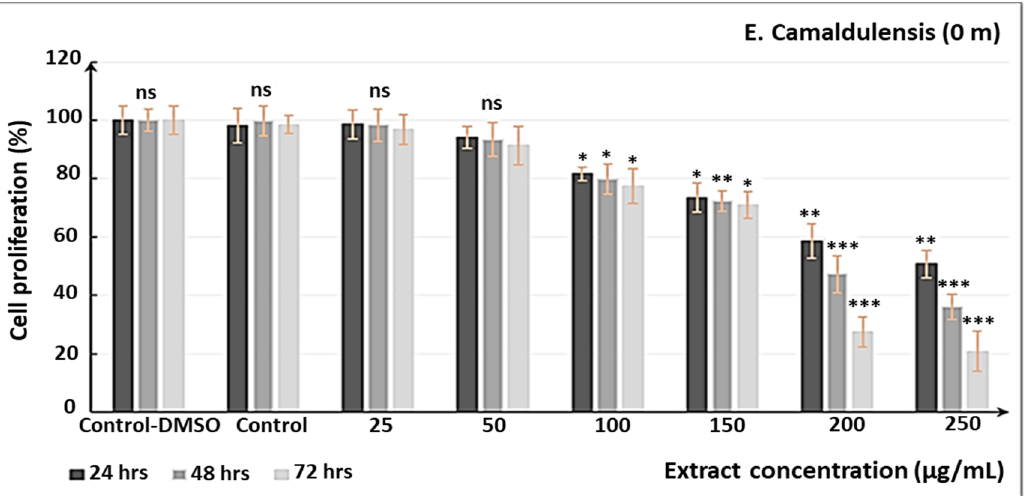
Figure 6 . Cell proliferation of A549 cells after the exposure to ethanolic extract of E. camaldulensis (0 m) for 24, 48 and 72 h. Peak values are represented as mean +/ − SD. Statistical analysis: Paired t test or Wilcoxon test. * p < 0.05; ** p < 0.01; *** p < 0.001 in which percentage of proliferation of treated cells is compared with that of control-DMSO at 24, 48, or 72 h. ns refers to non-significant result.